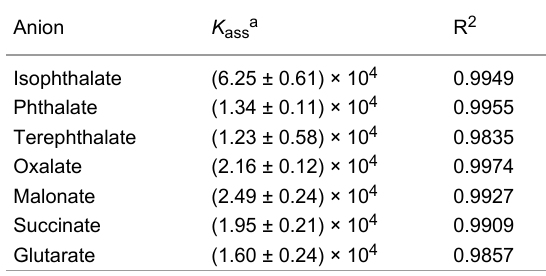
Table 1: Association constants K ass (M − 1 ) of sensor 1 with various dicarboxylates (as their tetrabutylammonium salts) in CH 3